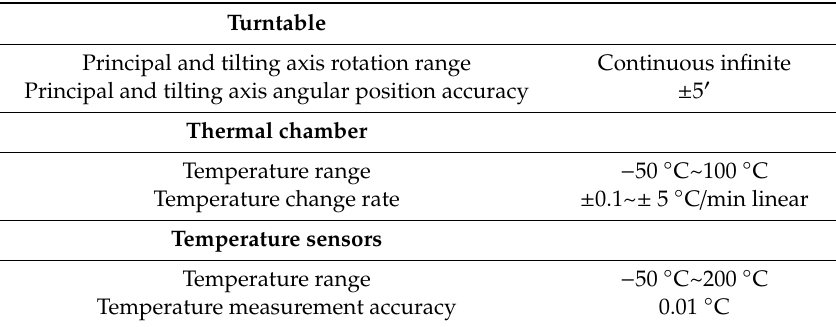
Table 2. The performance of thermal calibration